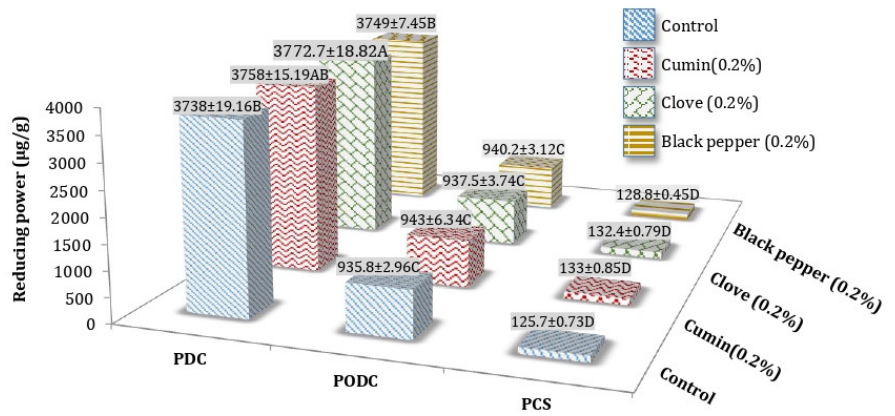
Figure 5. Mean values for Reducing power (RP) (µg/g Trolox equivalent) of processed Cheddar cheese (PCS), orally digested (PODC), and duodenal digested Cheddar cheese (PDC) made from buffalo milk after ripening. A–D means followed by the same letter for the same parameter are not significantly different ( p < 0.05).